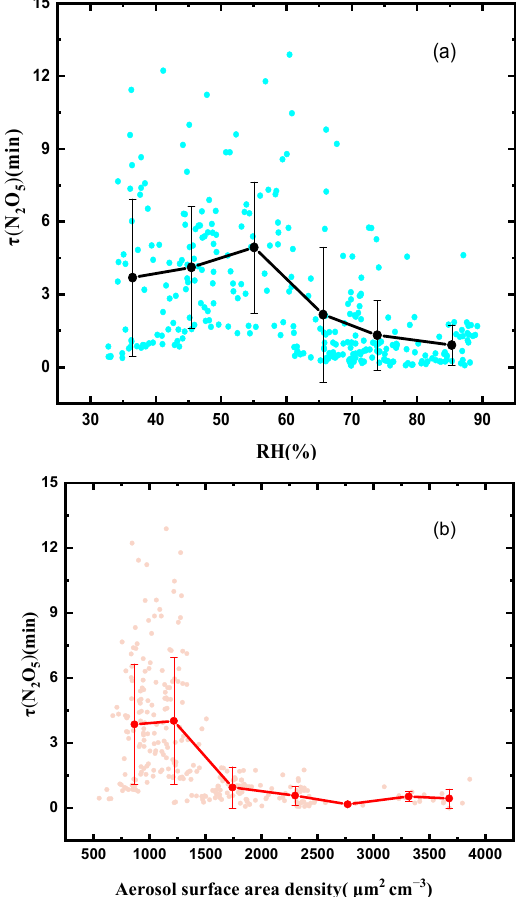
Figure 7. Scatter plots of the N 2 O 5 lifetime versus RH ( a ) and scatter plots of the N 2 O 5 lifetime versus Sa ( b ).